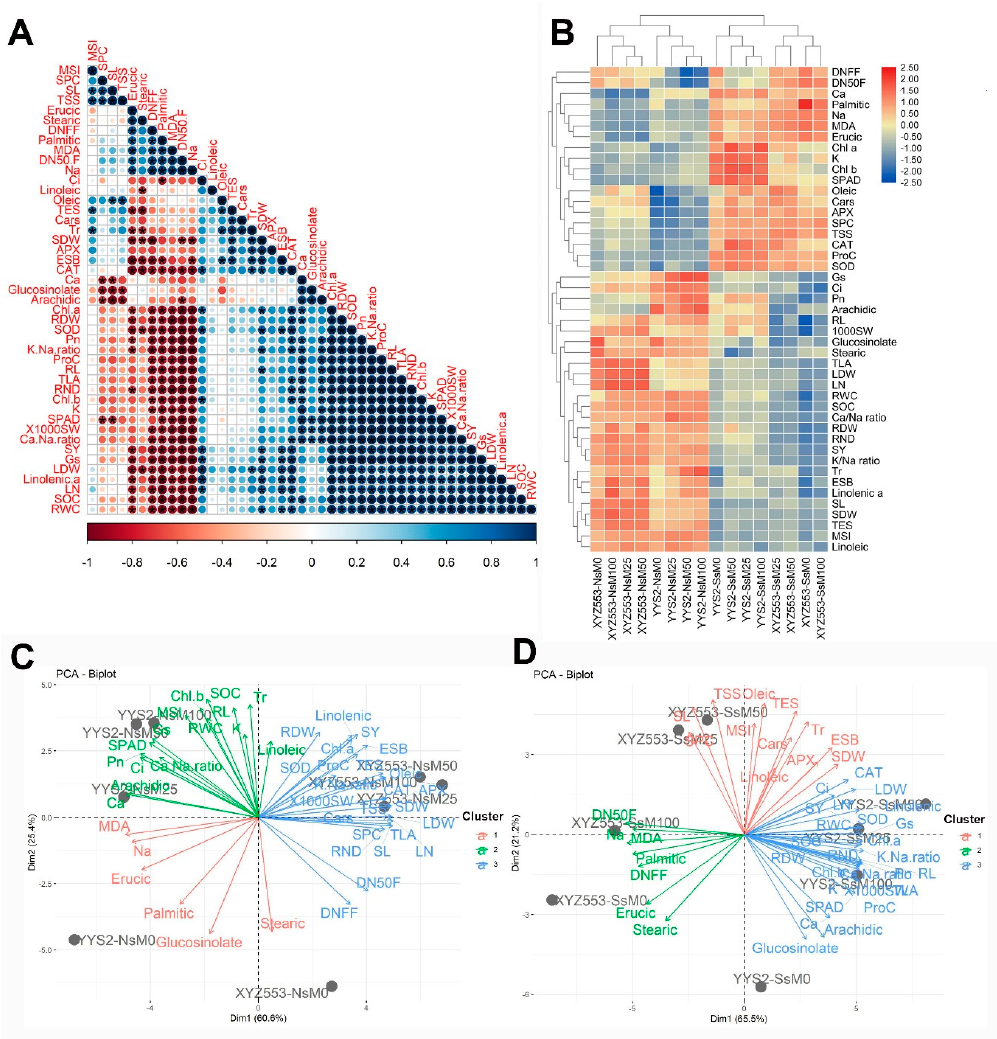
Figure 8. Relationship graphs. ( A ) Pearson’s correlation among different studied parameters under NaCl stress. ( B ) Heat map shows a hierarchical clustering analysis between studied parameters and treatments. ( C ) and ( D ) Biplot of different studied parameters for each treatment (n = 3), showing the first two dimensions (Dim1 and Dim2) of the principal component analysis (PCA) model for both cultivars grown under normal and NaCl stress, respectively. The colours represent variations in the data. * : p ≤ 0.05. DNFF: days number to the first flower, DN50F: days number to 50% flowering, RL: